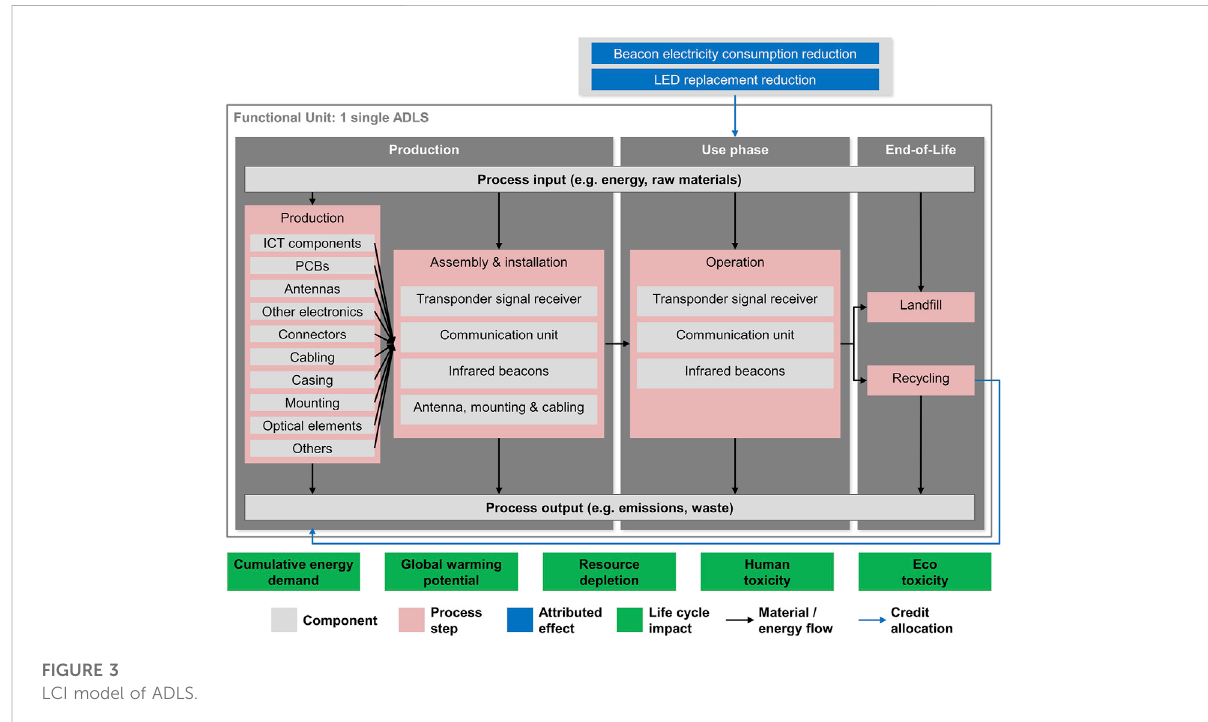
FIGURE 3 LCI model of